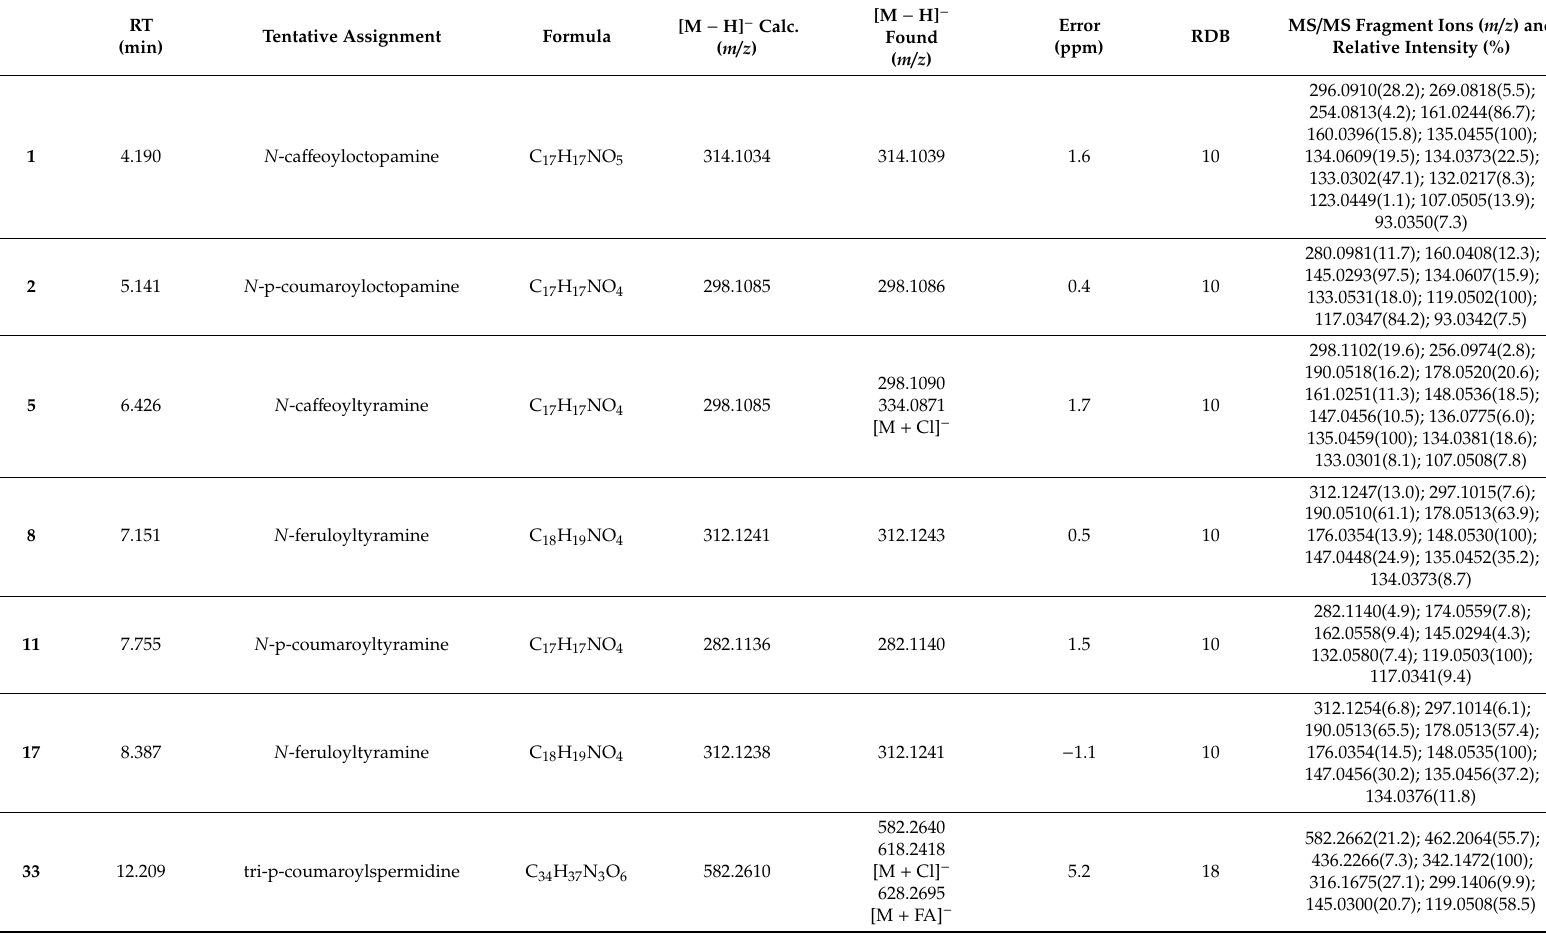
Table 1. TOF-MS and TOF-MS / MS of tentatively identified phenylamides in the investigated hempseed fraction. RT = Retention Time; RDB = Ring Double Bond equivalent value. Compounds were numbered based on their RT in the whole LnHS